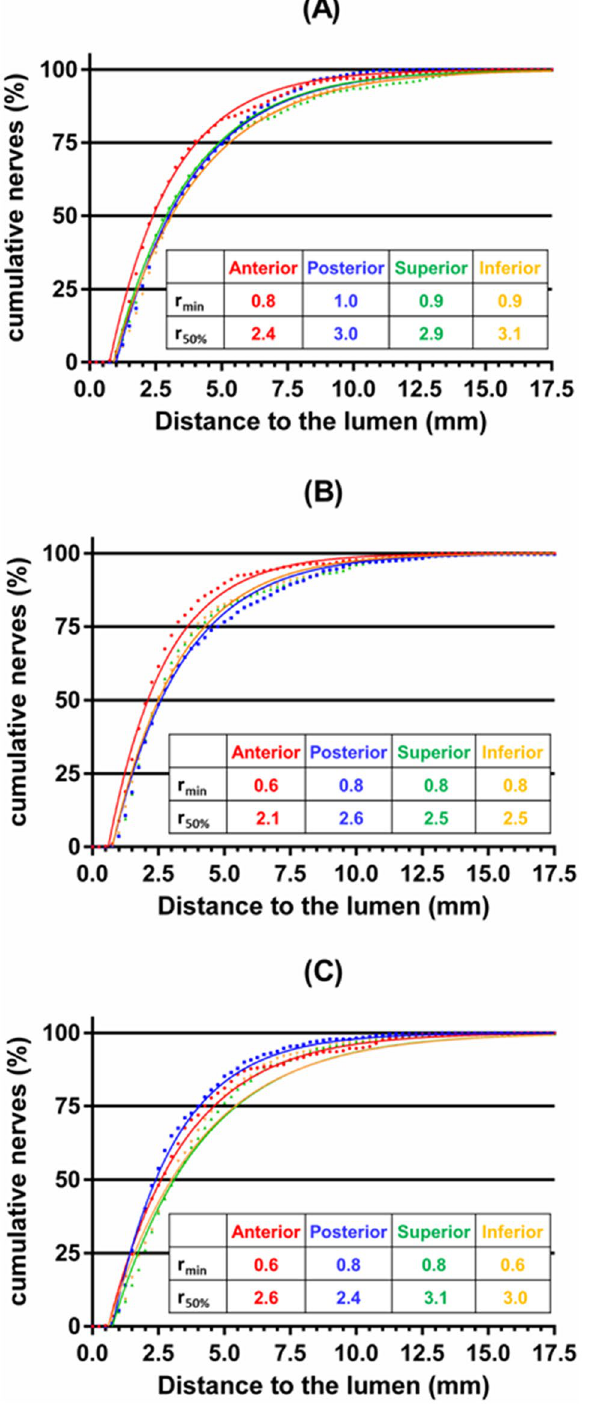
Figure 2. Radial nerve distribution varies with orientation and distance from aortic ostium. Composite radial nerve distributions are plotted for each of the four quadrants of the ( A ) proximal, ( B ) middle and ( C ) distal segments of the CHA. Composite data sets are depicted in 0.25 mm bins (dots) and contrasted with Eq. (1) (solid lines) using the tabulated minimal ( r min ) and median ( r 50% ) nerve distances directly obtained from the